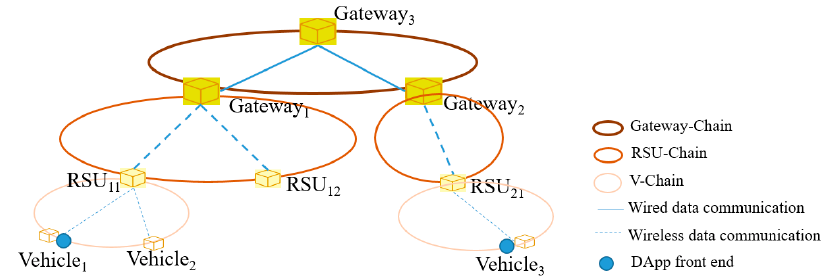
Figure 6. Topology of a vehicular network with ten blockchain nodes.